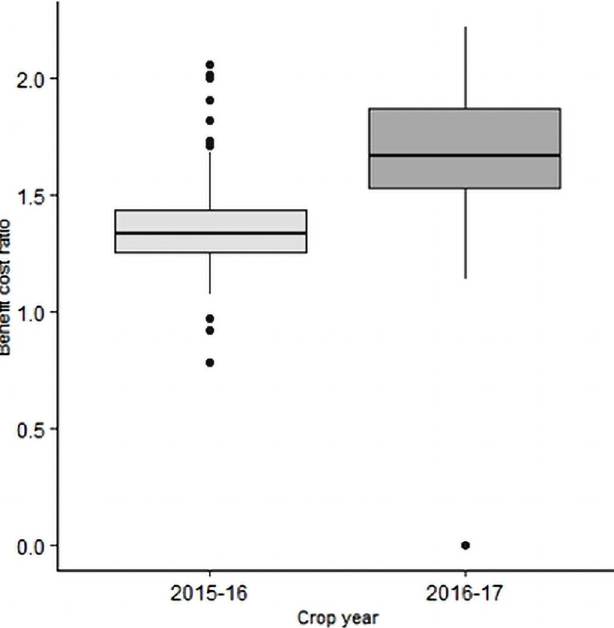
Fig 5. Variation in average benefit-cost-ratio of Boro rice cultivation during 2015–16 and 2016–17 for all plots of all locations. Boxes have horizontal bounds from first quartile (Q1) to third quartile (Q3). The horizontal line at the middle of the boxes represent the median. The dots represent the outliers in the data.